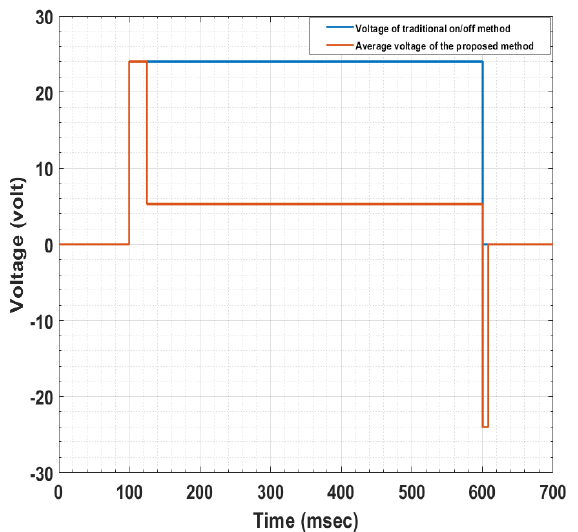
Figure 123. The solenoid delivered voltage using the traditional on/off method, and the average delivered voltage when using the proposed control method.